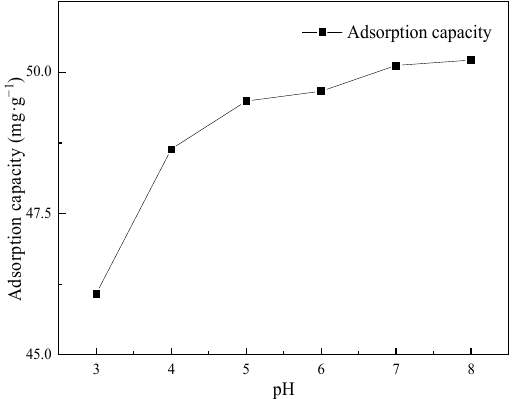
adsorption capacity of glutamic acid coupled chitosan modified activated carbon on Cd(II) and the initial pH value is consistent with this study [55].